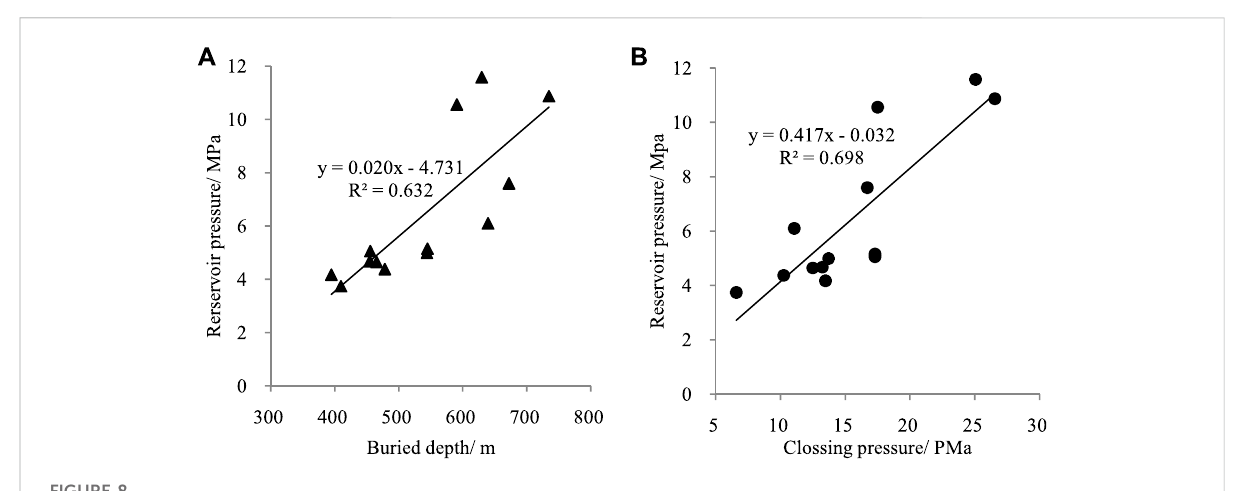
FIGURE 8 Fitting diagram of reservoir pressure versus burial depth (A) and crustal stress (B)